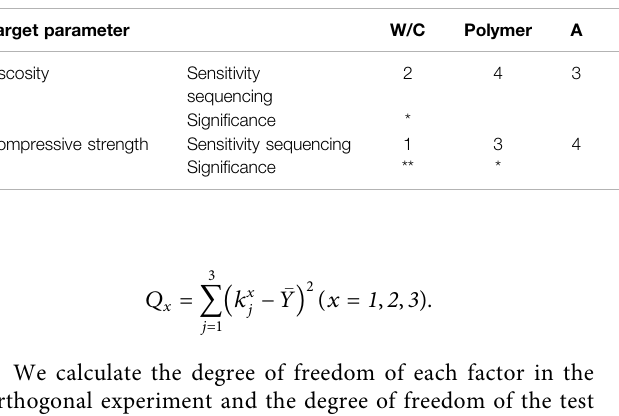
Frontiers in Materials |